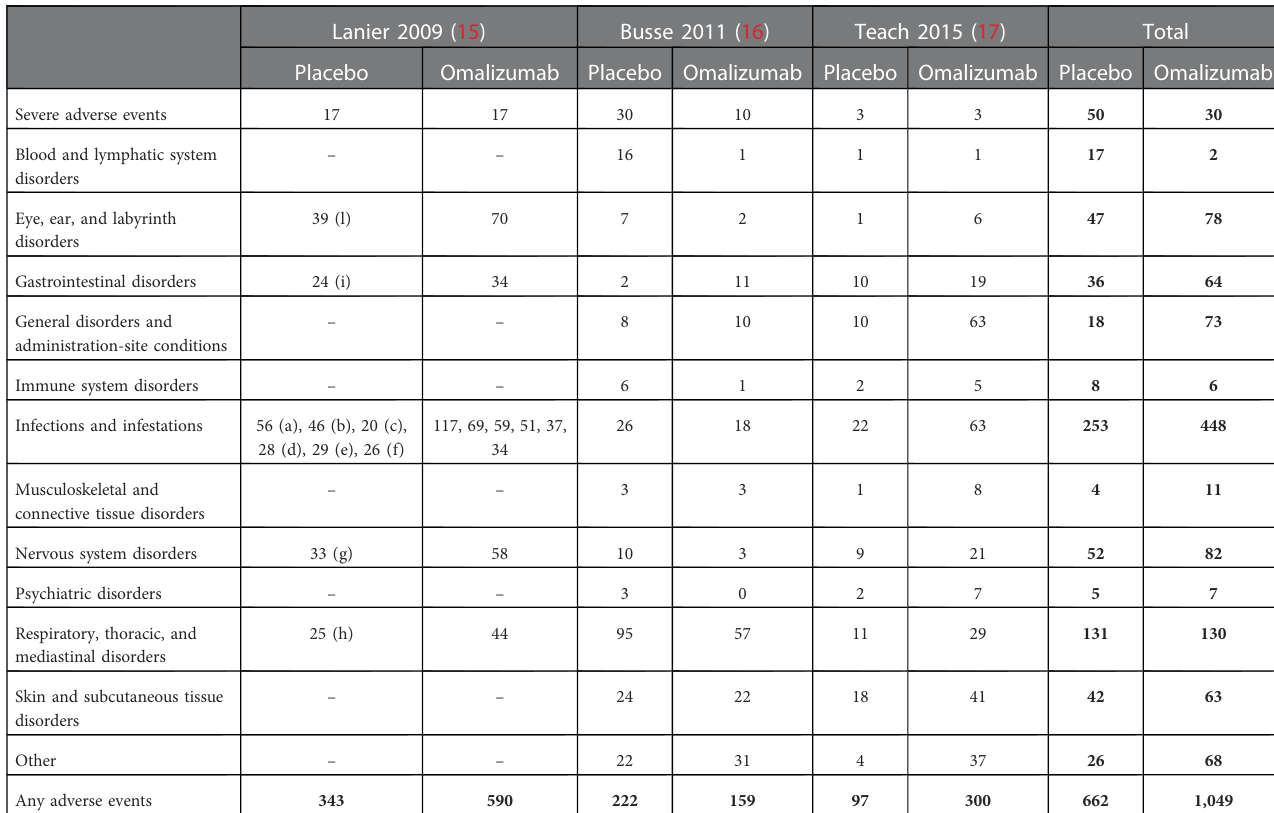
TABLE 2 Adverse events reported in the included